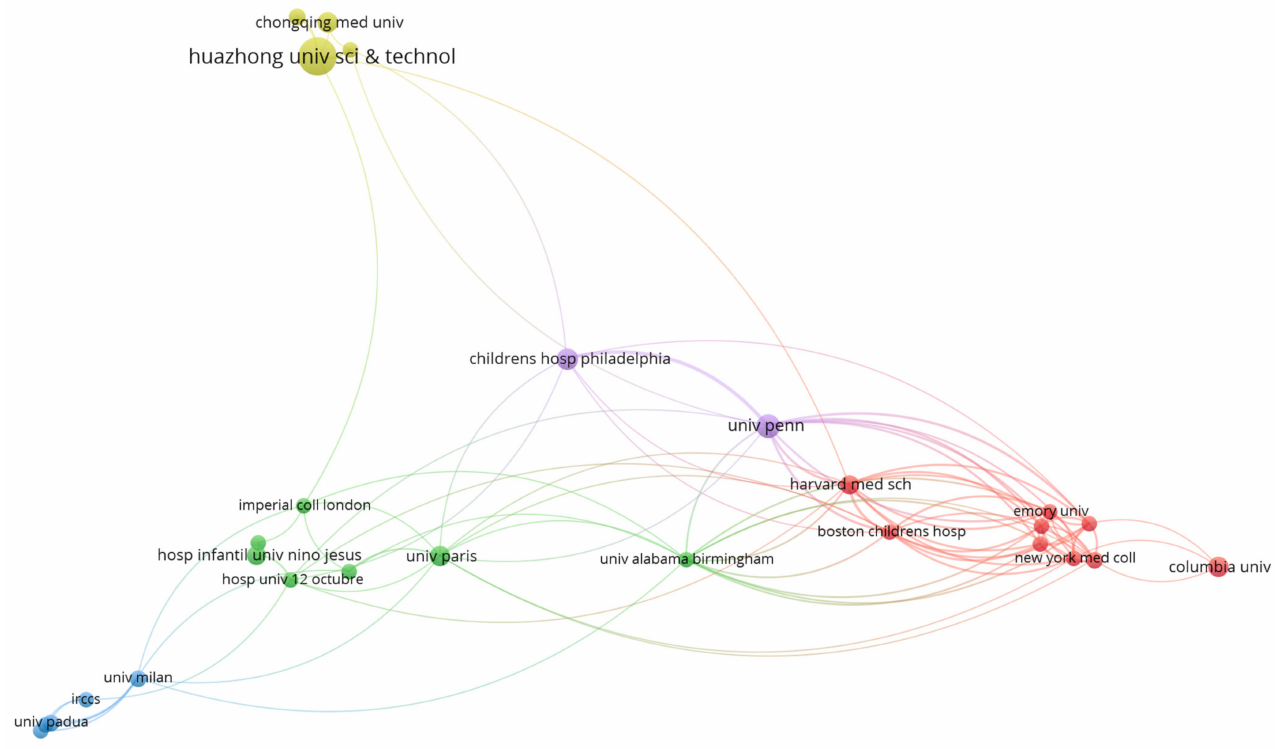
Figure 2. VOSviewer network visualization map of institutions/organizations (type of analysis: co-authorship, weights—documents, minimum number of documents of a country—5, 32 institutions meet the threshold, largest set of connected items—27). Groups of organizations that are strongly related to each other are represented using the same color (red, blue, green,